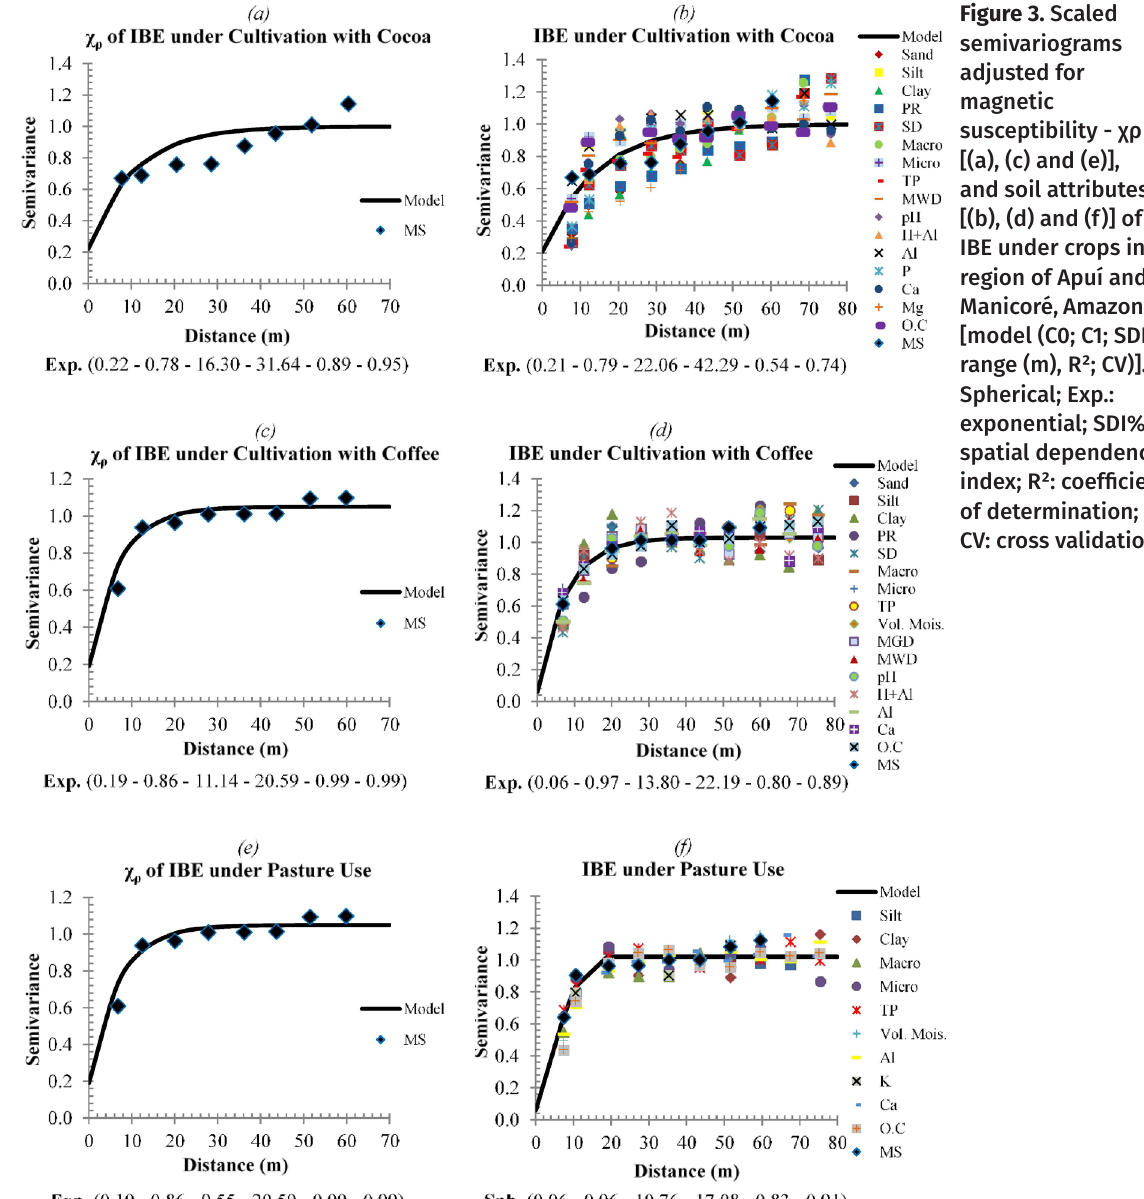
Figure 3. Scaled semivariograms adjusted for